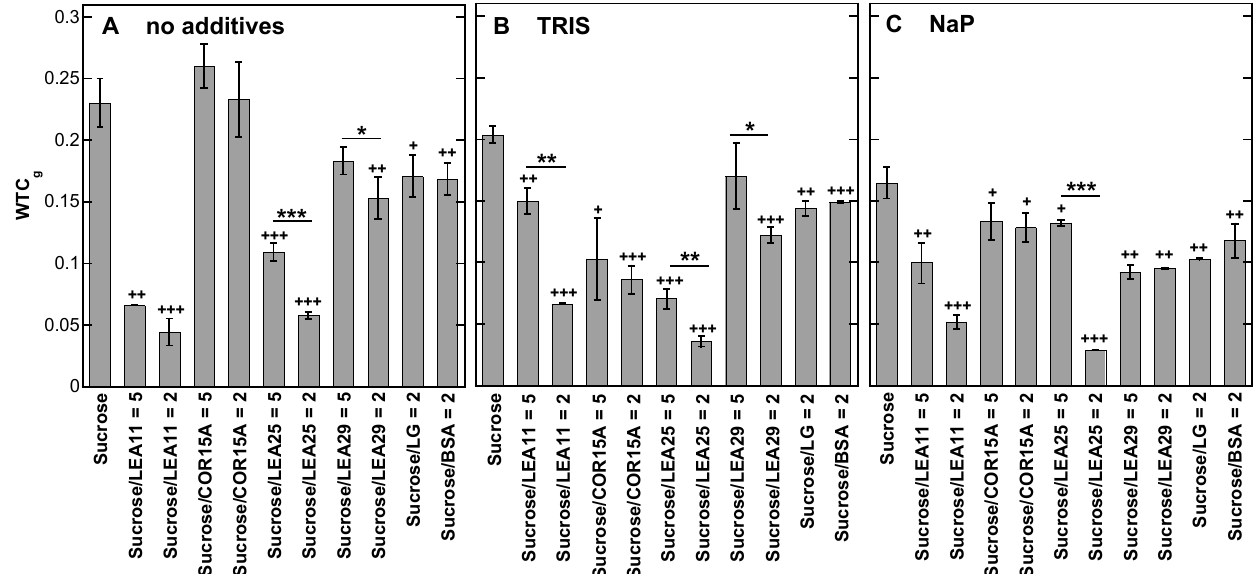
Figure 4. Wavenumber-temperature coefficients in the glassy state (WTC g ) of dry Suc. Samples contained either pure Suc or, in addition, the proteins LEA11, COR15A, LEA25, LEA29, β -lactoglobulin (LG) or bovine serum albumin (BSA). All solutions contained 10 mg/mL Suc and were prepared in H 2 O ( A ), 10 mM Tris ( B ) or 10 mM NaP buffer (pH 7.4) ( C ). In addition, samples contained proteins at the indicated Suc/protein mass ratios. Samples were dried on CaF 2 windows. The bars indicate the means from at least three samples ± standard deviation. Statistically significant differences between the values determined at the two different Suc/LEA mass ratios are indicated by *, while significant differences between the values obtained in the presence of the different proteins and pure Suc are indicated by + (*, + ˂ 0.05; **, ++ ˂ 0.01, ***, +++ ˂ 0.001).